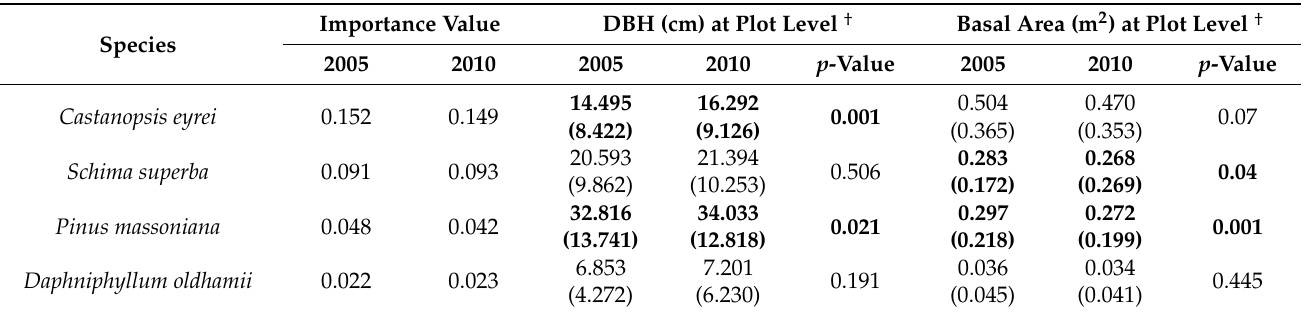
Table 1. Importance values, plot-level DBH, and plot-level basal area of the four canopy dominant species in 2005 and